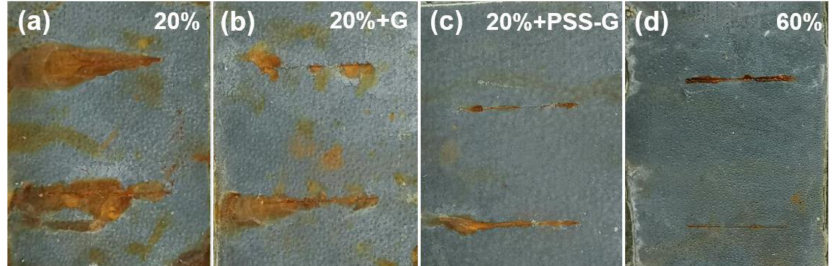
Figure 9. Visual performance of the epoxy zinc-containing coatings with ( a ) 20% zinc content, ( b ) epoxy / G coatings, ( c ) epoxy / PSS-G coatings and ( d ) epoxy zinc-containing coatings with 60% zinc content exposed to neutral salt spray for 1000